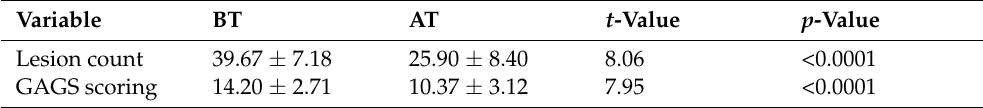
Table 1. Total lesion count and GAGS score before and after treatment in the acne group. Variable BT AT t -Value p -Value Lesion count 39.67 ± 7.18 25.90 ± 8.40 8.06 <0.0001 GAGS scoring 14.20 ± 2.71 10.37 ± 3.12 7.95